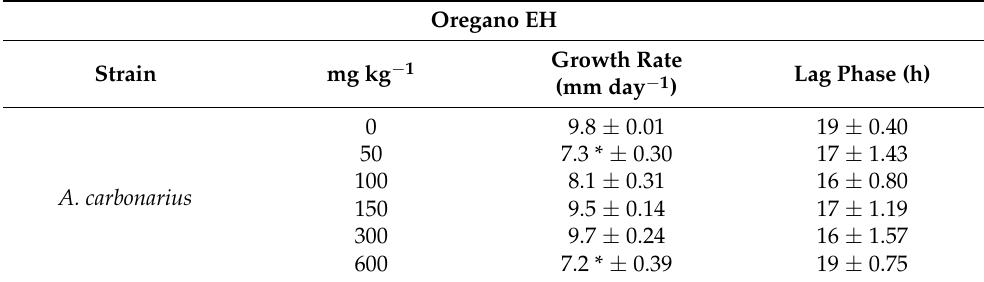
Table 7. Effect of oregano hexanic plant extraction on lag phase and growth rate of A. carbonarius at different